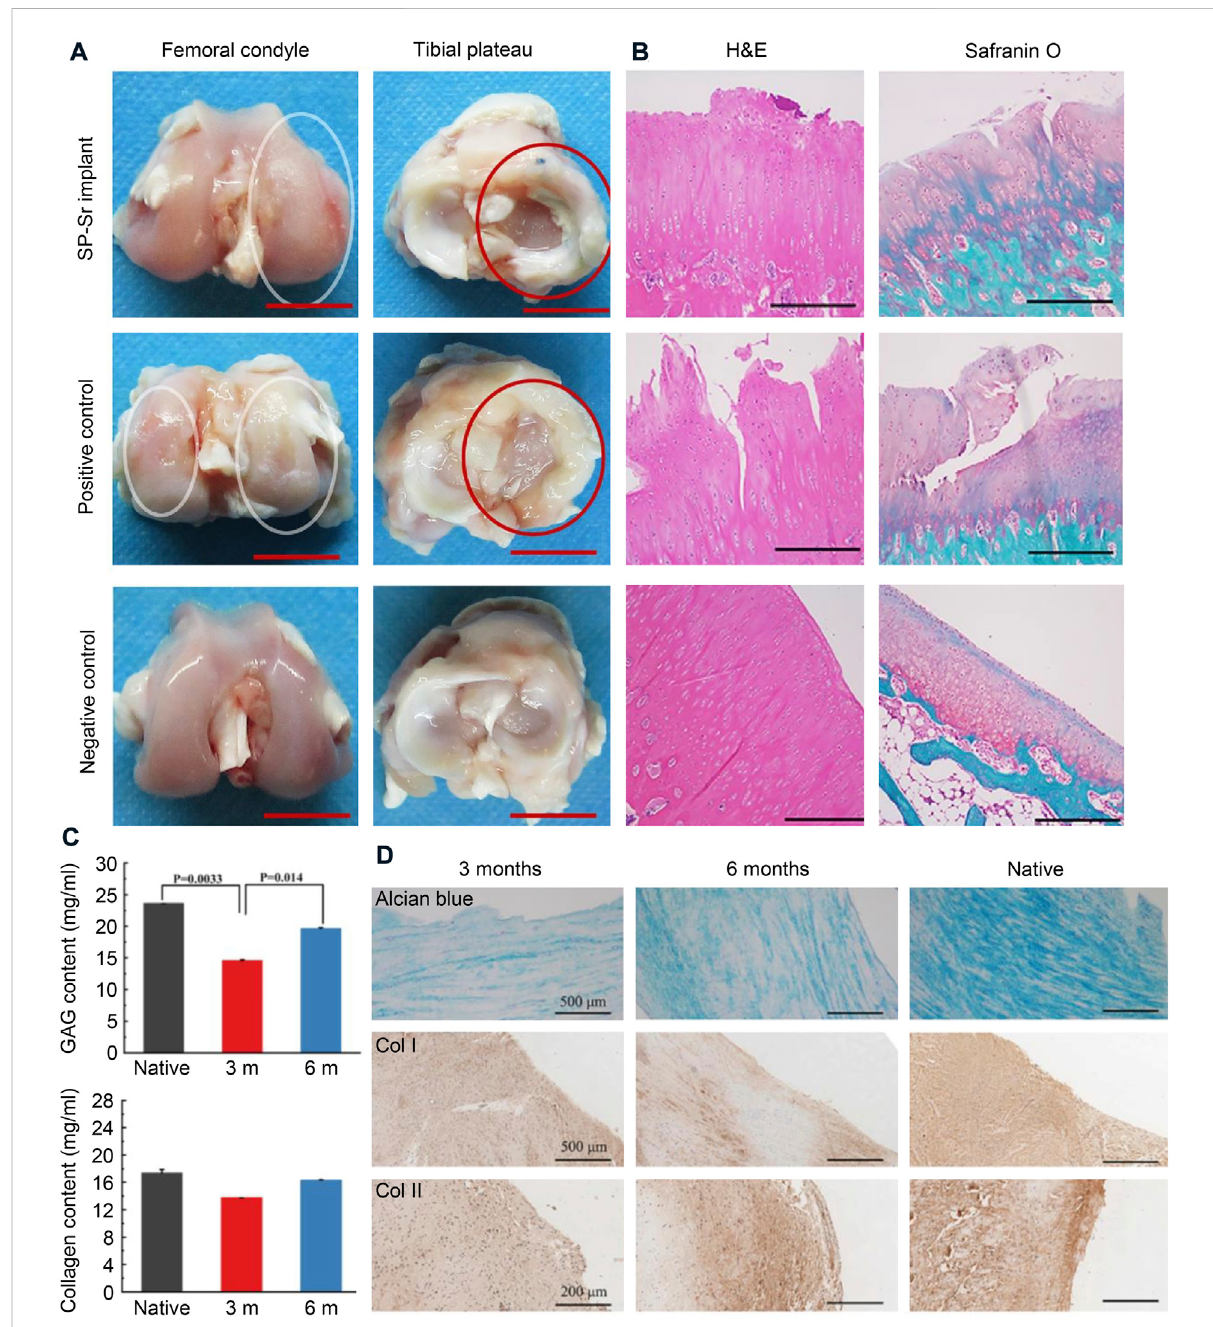
FIGURE 6 Silk materials used for meniscus tissue engineering. (A) Macroscopic observations of regenerated menisci and the corresponding femoral condyles. The red ellipses referred to themeniscus and the white ellipses referred to worn cartilage. Bars = 1 cm. (B) H&E and Safranin O-FastGreen staining of articular cartilage surfaces in the femur cartilage. Bars = 500 μ m. (C) The total GAG and collagen content were estimated in native meniscus and neomeniscus. (D) The alcian blue and immunohistochemical staining in native meniscus and neomeniscus. Reprinted with permission (Y. Li Y et al., 2020). Copyright (2017),